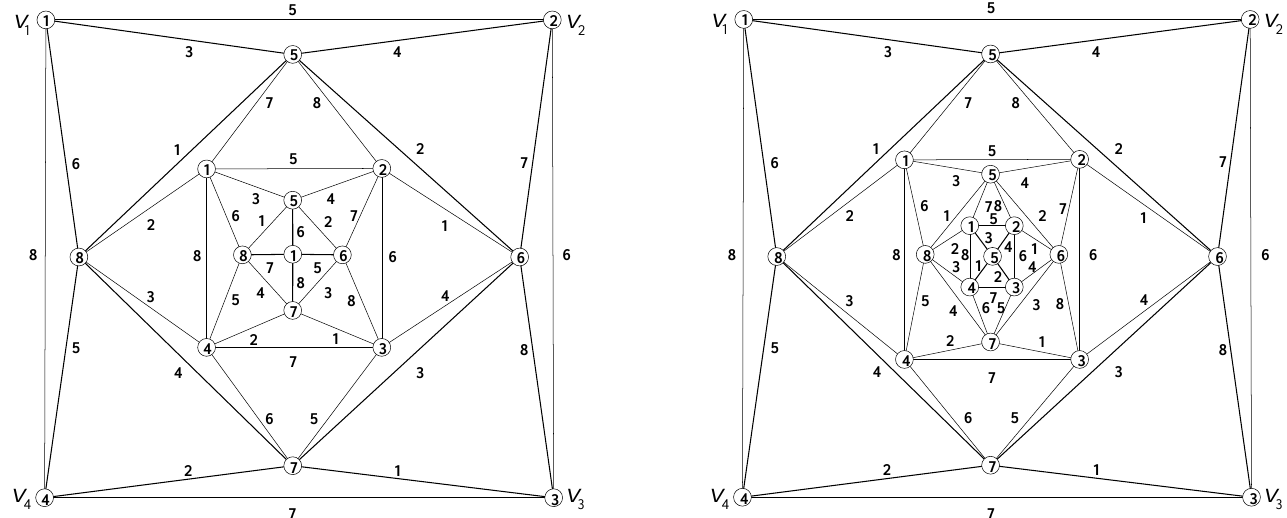
Figure 9. The coloring diagram for l = 3 and l =